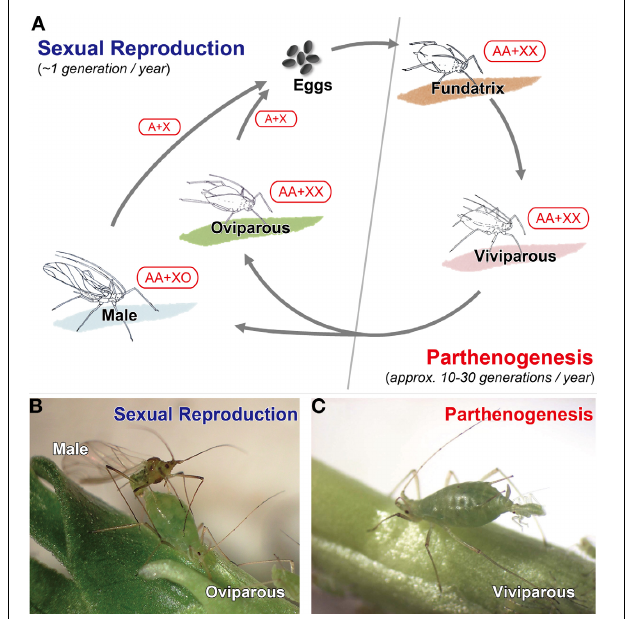
FIGURE 1 | Typical annual life-cycle of aphids. (A) Schematic diagram of a typical holocyclic life cycle of aphids, (B) sexual individuals (male and oviparous female) of Acyrthosiphon pisum , (C) viviparous female of A. pisum . Aphids reproduce by thelytokous parthenogenesis in spring and summer under conditions of long day length and high temperatures. In aphids with a holocyclic life cycle, males and oviparous (sexual) females appear in late autumn and produce fertilized eggs for overwintering. Aphids employ the XO sex-determination system. Therefore, viviparous and oviparous females possess two X chromosomes, while males possess only one X chromosome. Males are produced parthenogenetically with the random loss of one X chromosome during the maturation division. Although oviparous females and males produce haploid oocytes and sperm, respectively, by reductive meiosis, only sperm possessing an X chromosome are viable (sperm lacking an X chromosome are degenerate). Therefore, the next generation, which will hatch as fundatrices in the spring, is entirely female (XX). Viviparous, viviparous parthenogenetic female; Oviparous, oviparous sexual